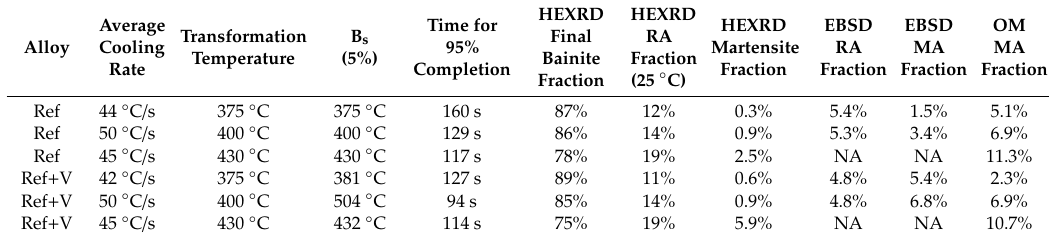
Table 3. Phase fractions from synchrotron high energy synchrotron X-ray di ff raction (HEXRD), EBSD and optical microscopy data.